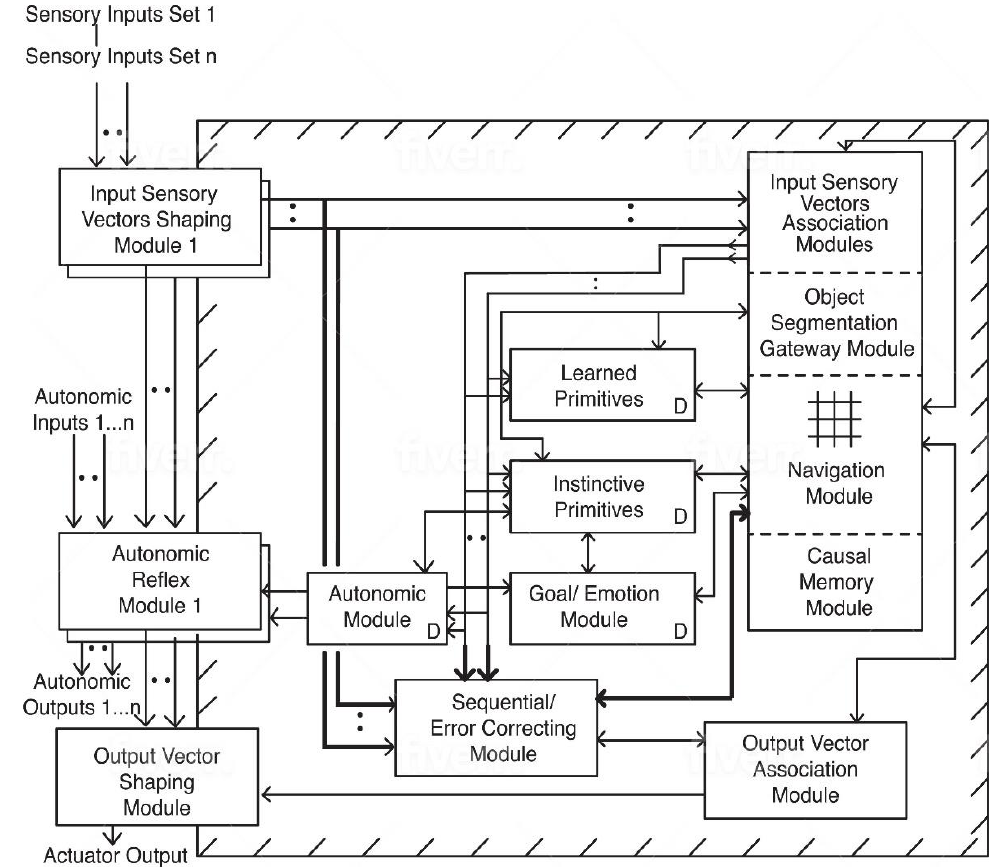
Figure 1. Overview of the Causal Cognitive Architecture 4 (CCA4).